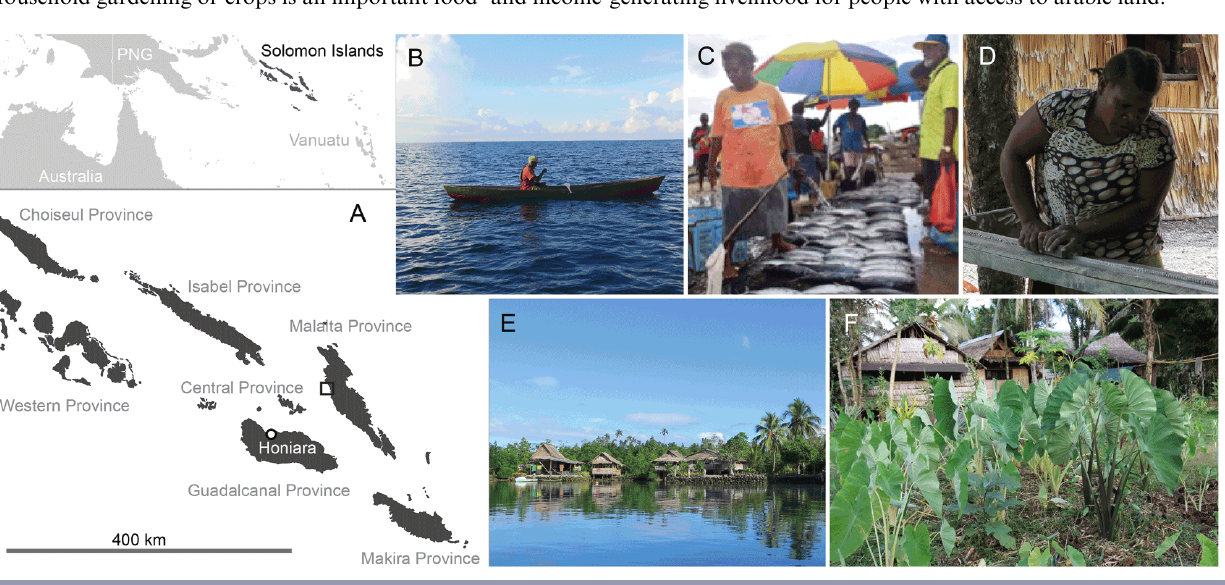
Fig. 1 . (A) Map of Solomon Islands. Location of Langalanga Lagoon indicated by square in Malaita Province. (B) Hook-and- line fishing over reef is a common fishing method. (C) Langalanga is adjacent to Auki, the main trading center of the province, where large volumes of fish are sold. (D) Woman shaping shell discs on a string for shell money ( tafuli’ae ) production, an important livelihood and cultural feature of the lagoon. (E) Many households reside on artificial islands in the lagoon. (F) Household gardening of crops is an important food- and income-generating livelihood for people with access to arable